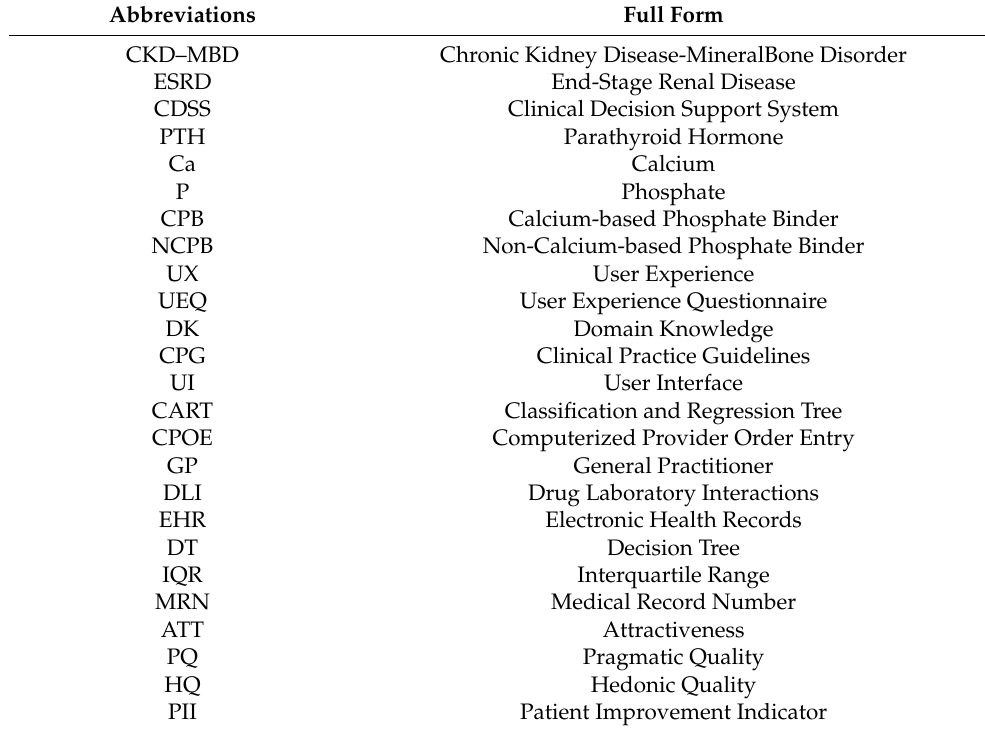
Table 1. A list of abbreviations used in this